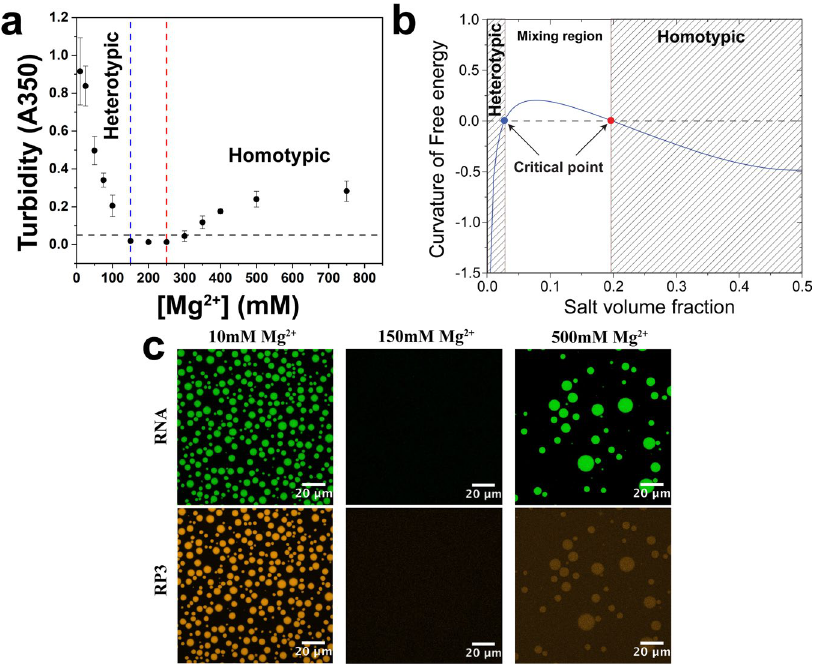
Figure 2. Magnesium drives a switch-like behavior in RNA droplets, creating distinct RNA coacervates. ( a ) Solution turbidity measurements of a sequential MgCl 2 titration showing a window of miscibility (150–250 mM MgCl 2 ), indicative of droplet switching. ([RP3] = 500 µ M, 2x polyU wt/wt). ( b ) Theoretical free energy curvature vs. salt volume fraction calculated using a model (SI Note 1) based on Voorn-Overbeek theory of complex coacervation in the context of Flory-Huggins mean field theory. ( c ) Confocal fluorescence images of Mg 2 + -dependent droplet switching. ([RP3] = 500 µ M, 2x polyU wt/wt, 0.5 µ M RP3-AF594, 0.5 µ M FAM-